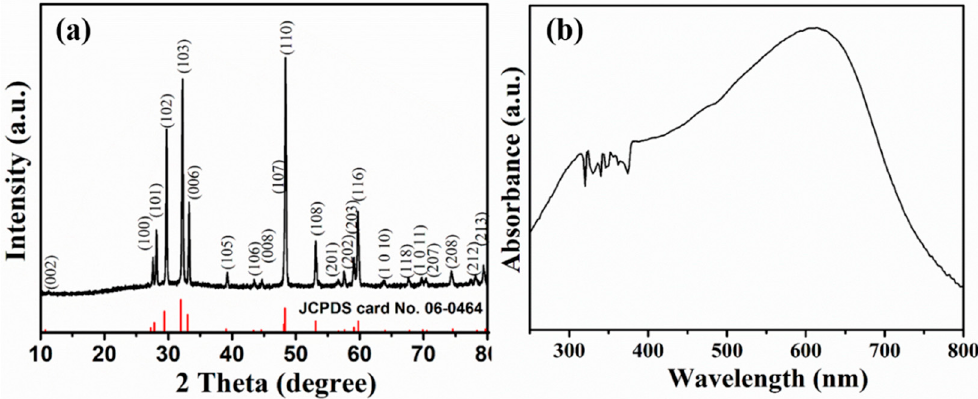
Figure 1. ( a ) XRD pattern and ( b ) UV-vis spectra of the prepared CuS.